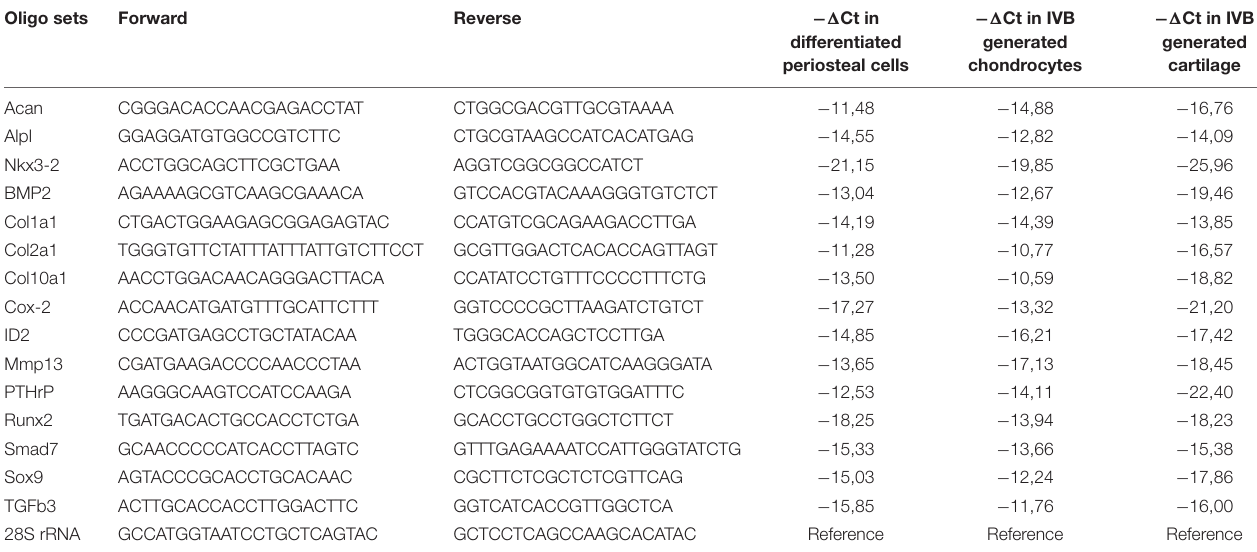
TABLE 1 | Primer sequences for RT-qPCR. Oligo